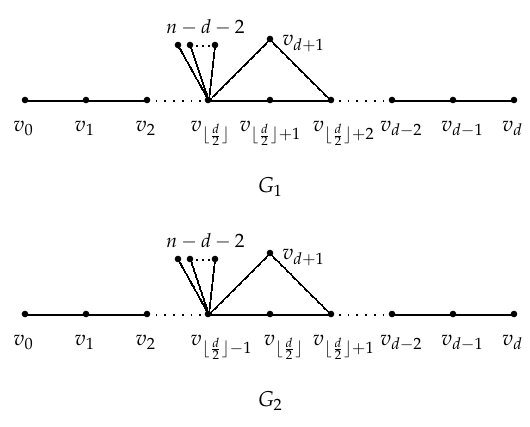
Figure 4. Graphs G 1 and G 2 .